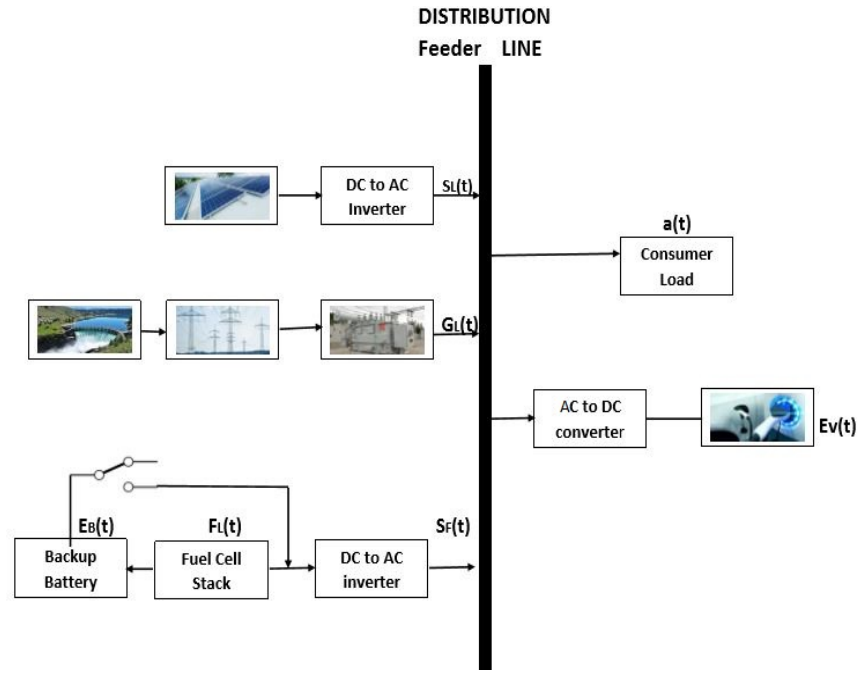
Figure 2. Sustainable distributed energy model for smart grid application.